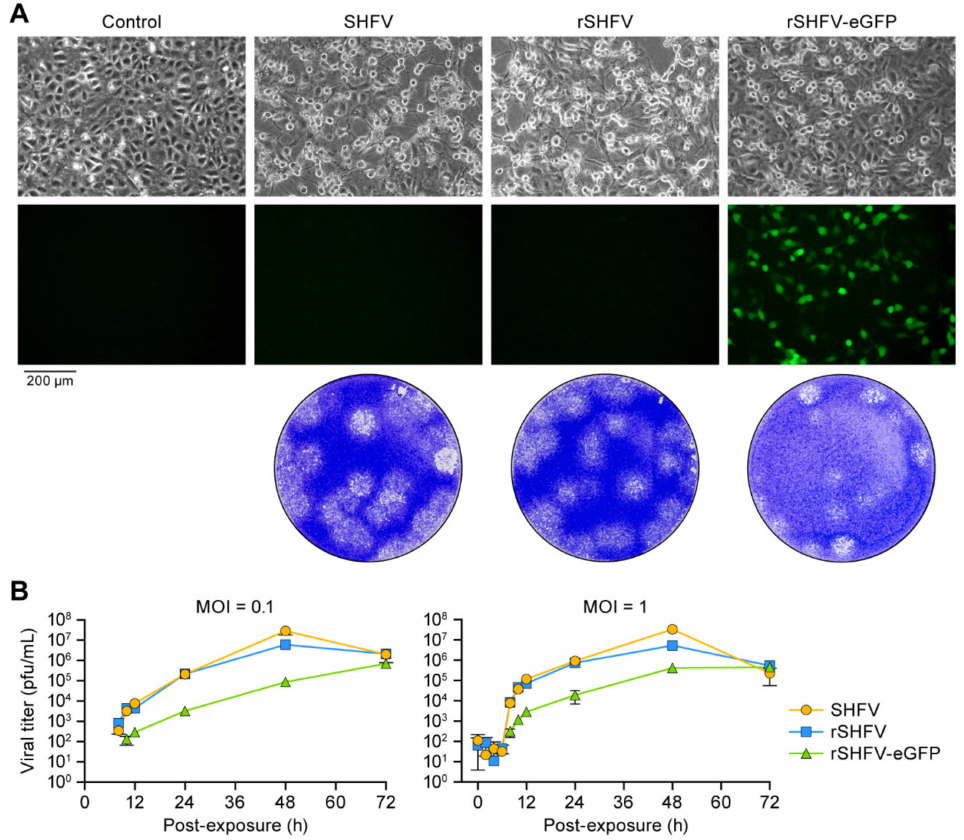
Figure 2. Growth kinetics of wild-type simian hemorrhagic fever virus variant NIH LVR42-0/M6941 (SHFV), recombinant wild-type SHFV (rSHFV), and rSHFV expressing enhanced green fluorescent protein (rSHFV-eGFP). ( A ) MA-104 cells were mock-exposed (control), exposed to SHFV (multiplicity of infection (MOI) of 0.1), transfected with pCMV-SHFV, or transfected with pCMV-SHFV-eGFP. Top row: Microscopic images reveal the cytopathic effect caused by SHFV, rSHFV, and rSHFV-eGFP infection at 16 h post-exposure/transfection. Middle row: Expression of eGFP was observed using epifluorescent microscopy. Bottom row: plaque morphologies of the three viruses. ( B ) MA-104 cells were exposed to all three viruses at MOIs of 0.1 (left) and 1 (right), tissue culture supernatants were harvested at the indicated time points post-exposure, and virus titers were determined by plaque assay. Graphs of viral titers represent the means ± the standard deviations of triplicate samples from one of two independent